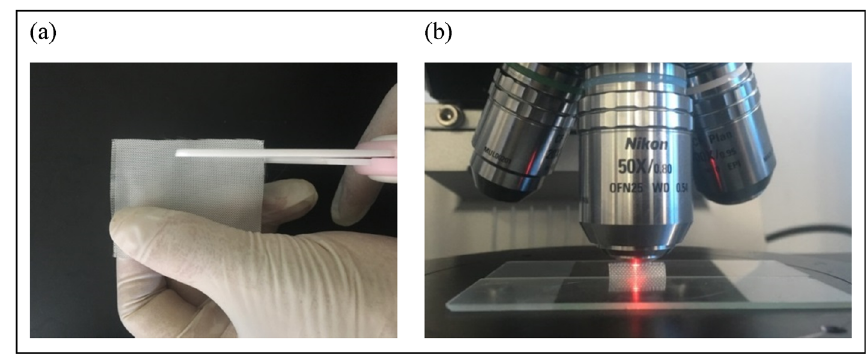
Figure 2: Fabric sample preparation. ( a ) Cutting fabric with ceramic scissors and ( b ) fabric clamped by two glass